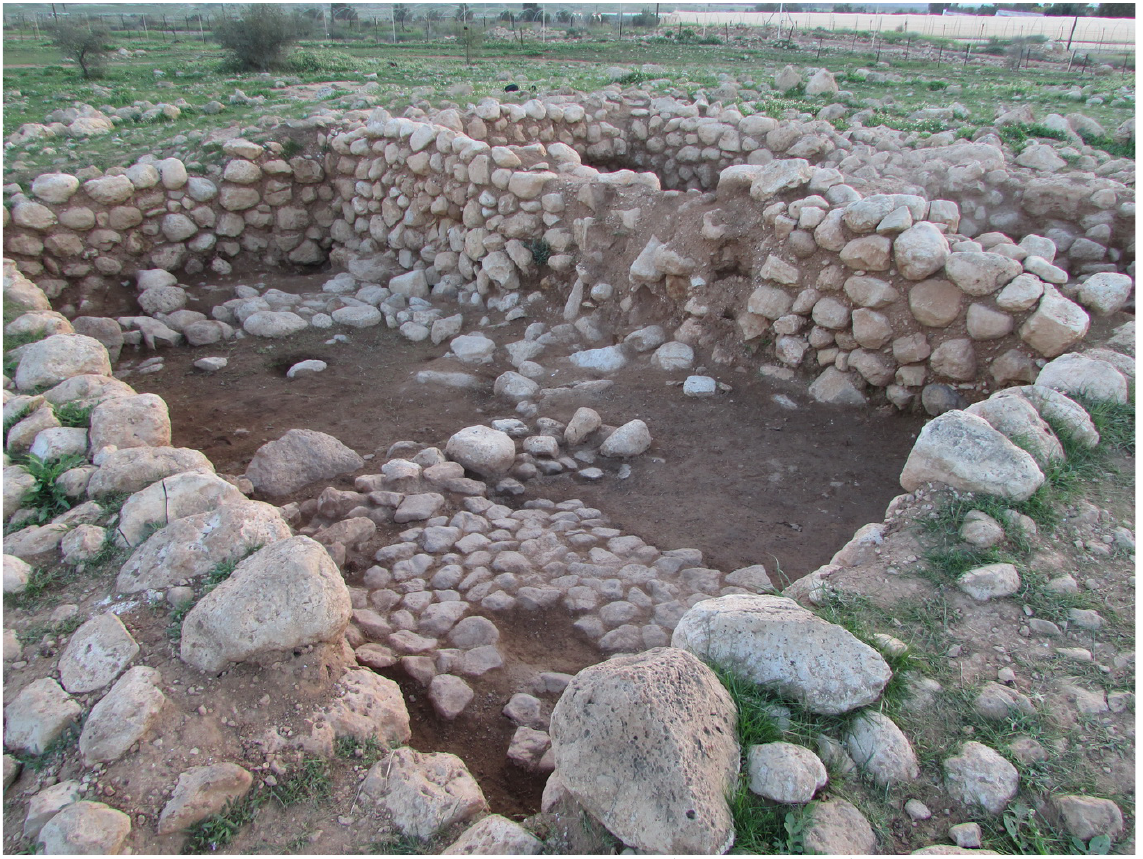
Figure 9. The northwestern room of the main building in Fazael 7 (looking northeast). Table 4: Distribution of ground stone tool types across strata in Fazael